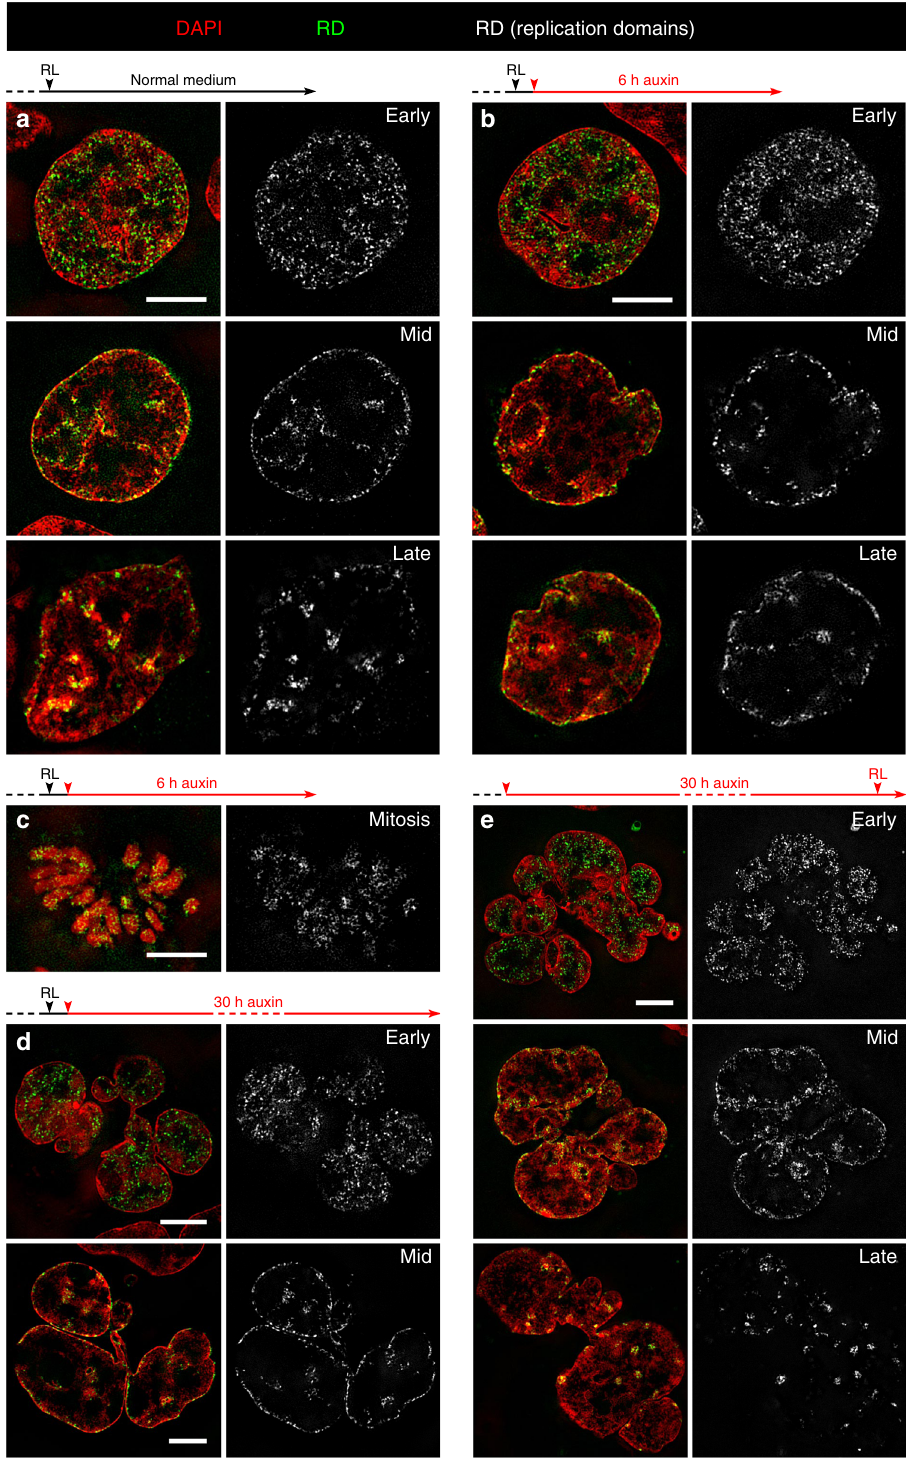
Fig. 6 Maintenance, postmitotic rebuilding and de novo formation of typical replication patterns after cohesin depletion. a – e Overlay images (left) show representative SIM sections of DAPI-stained nuclei (red) with replication domains (RDs)(green) identi fi ed by replication labeling (RL) in different stages of S-phase. RDs in the same nuclear sections are also displayed in gray (right). a Control nuclei fi xed 6 h after RL with typical patterns for early, mid and late replication, respectively. b Maintenance of the same typical replication patterns in nuclei of cohesin depleted, pre-mitotic cells fi xed 6 h after RL. c Cohesin depleted mitotic cell with replication labeled chromatin domains obtained under conditions as described in b . d RD patterns in individual lobuli demonstrate the ability of post-endomitotic MLN to restore RD patterns, generated by RL during the previous cell cycle. Cells were treated with auxin for 30 h after RL. e RL carried out with MLN obtained after ~30 h auxin treatment demonstrates de novo DNA synthesis with the formation of new typical replication patterns. Scale bar: 5 µ m. Images shown in a – e show representative nuclei from three independent